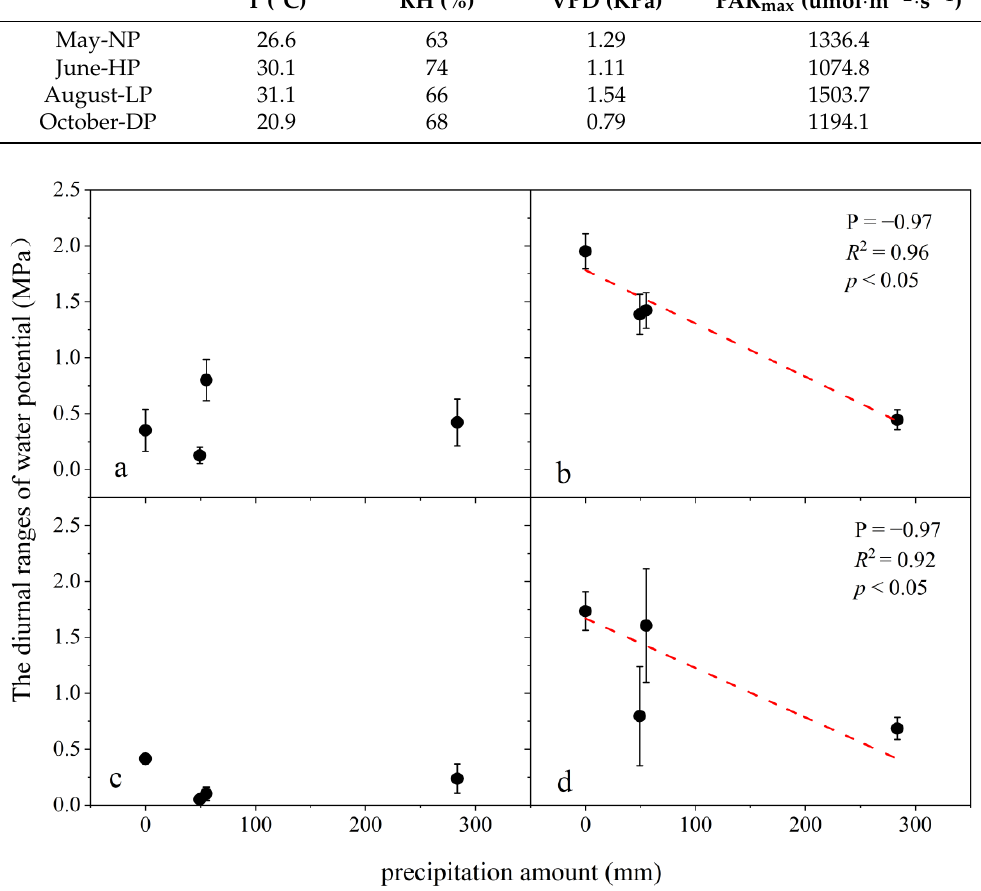
Figure 10. Relationships between the diurnal ranges of water potential (mean ± S.D.) and the precipitation amount ten days before sampling. P is Pearson correlation, R 2 represents the fitting degree of the relationship between the diurnal ranges of water potential and the precipitation amount; p is the p -value of the fitting (( a ) C. lanceolata in the edaphic habitat; ( b ) P. massoniana in the edaphic habitat; ( c ) C. lanceolata in the rocky habitat; ( d ) P. massoniana in the rocky habitat). Table 3. Relationship between water uptake depth and the diurnal ranges of water potential for C. lanceolata and P. massoniana in edaphic and rocky habitats. Edaphic Habitat ( − MPa) Rocky Habitat ( − Pearson Correlation